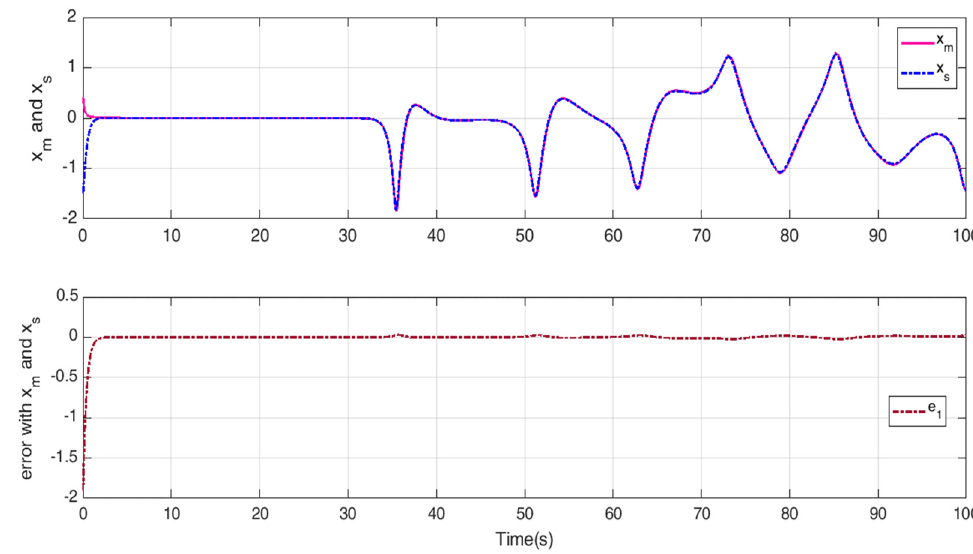
Figure 6. The master–slave synchronization of the first state.